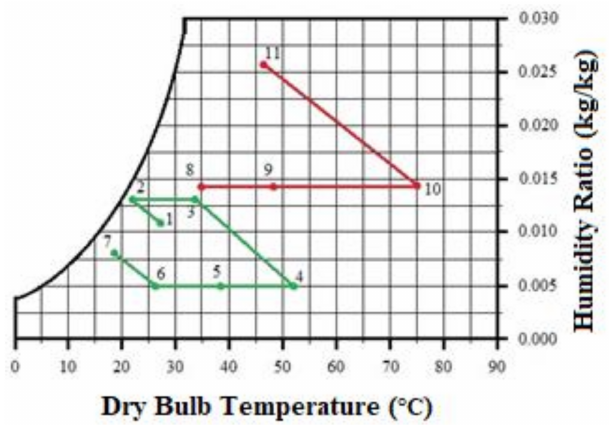
Figure 5. Dunkle Cycle.